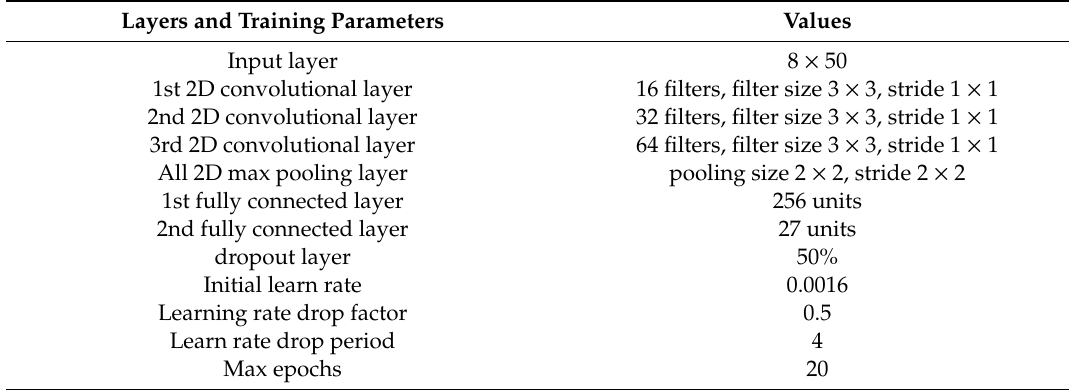
Table 3. Architecture and training parameters of the 2D convolutional neural network.